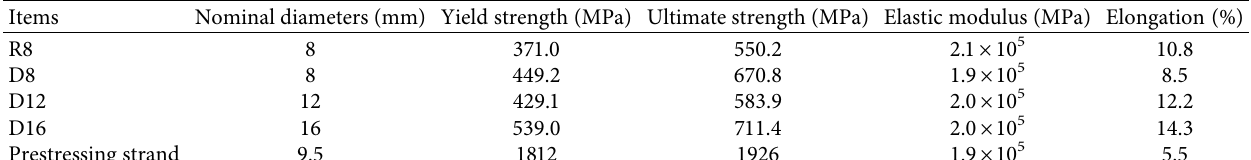
Table 2: Mechanical properties of reinforcement and prestressing